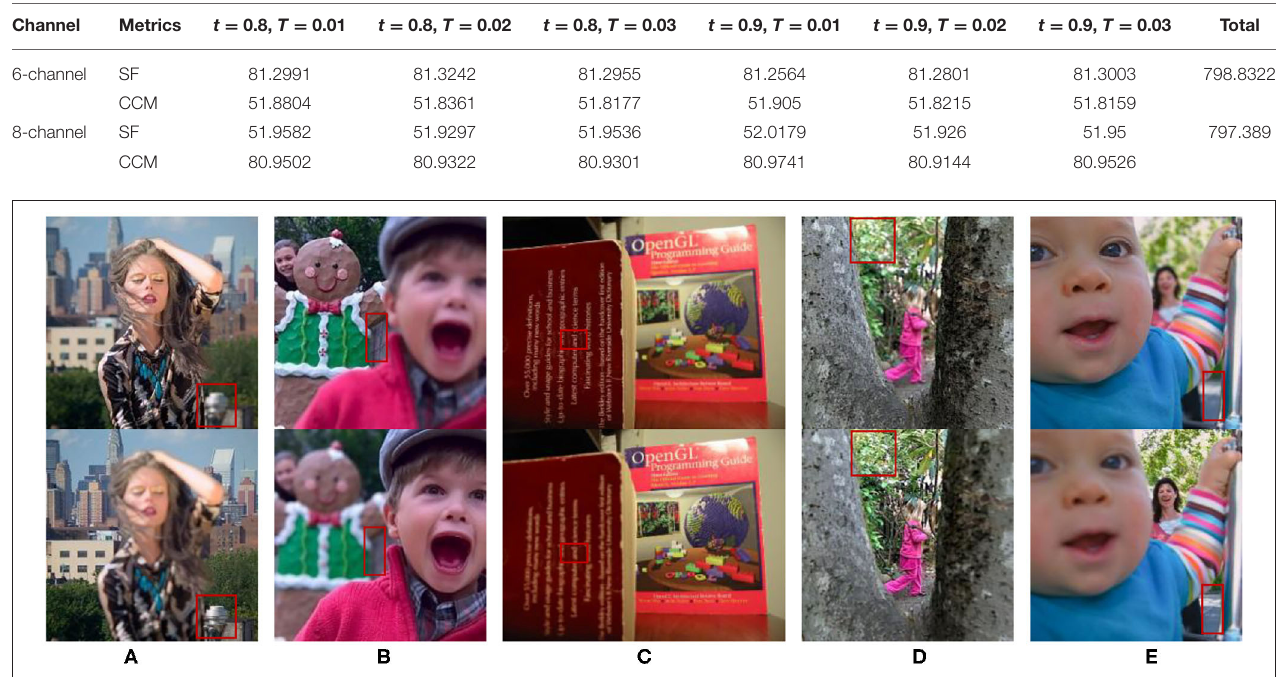
TABLE 2 | Selection of initial parameters (2).